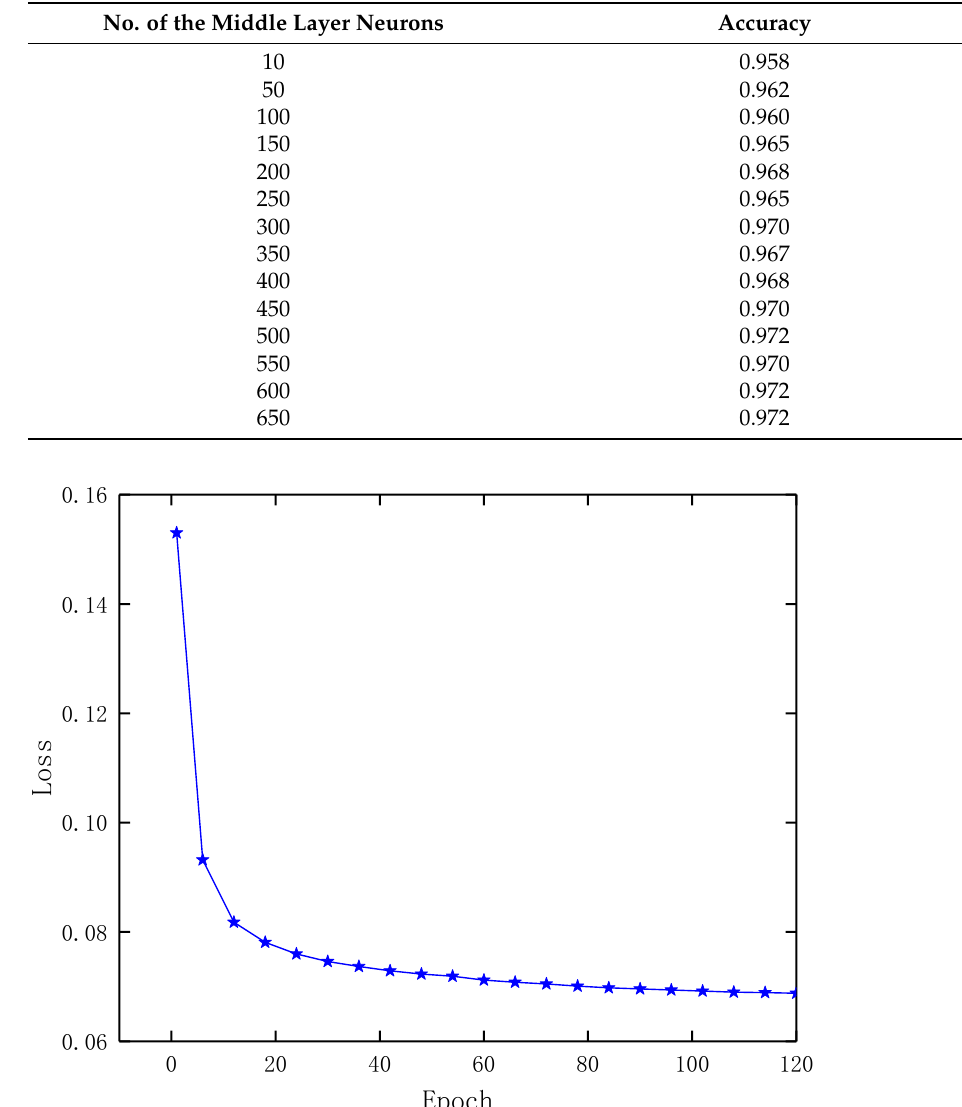
Figure 6. The convergency curve of loss function during training of the final determined CNNs.